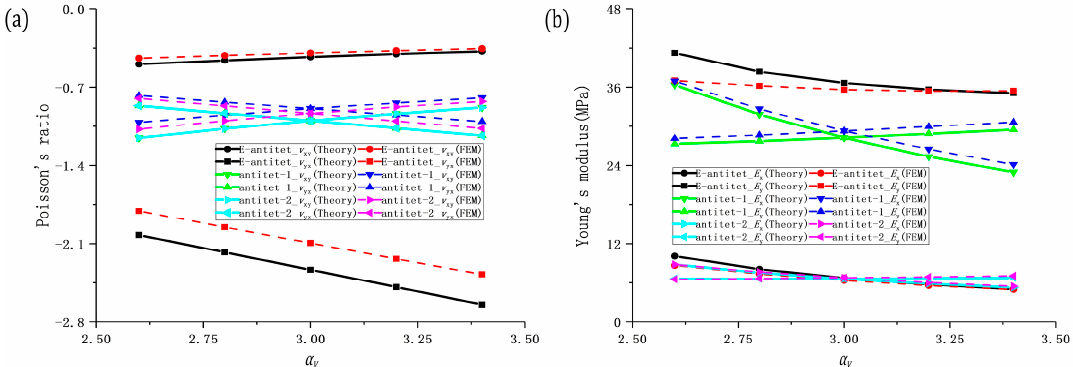
Figure 7. Trends of Poisson’s ratio and Young’s modulus of E-antitet at different α y : Comparison of